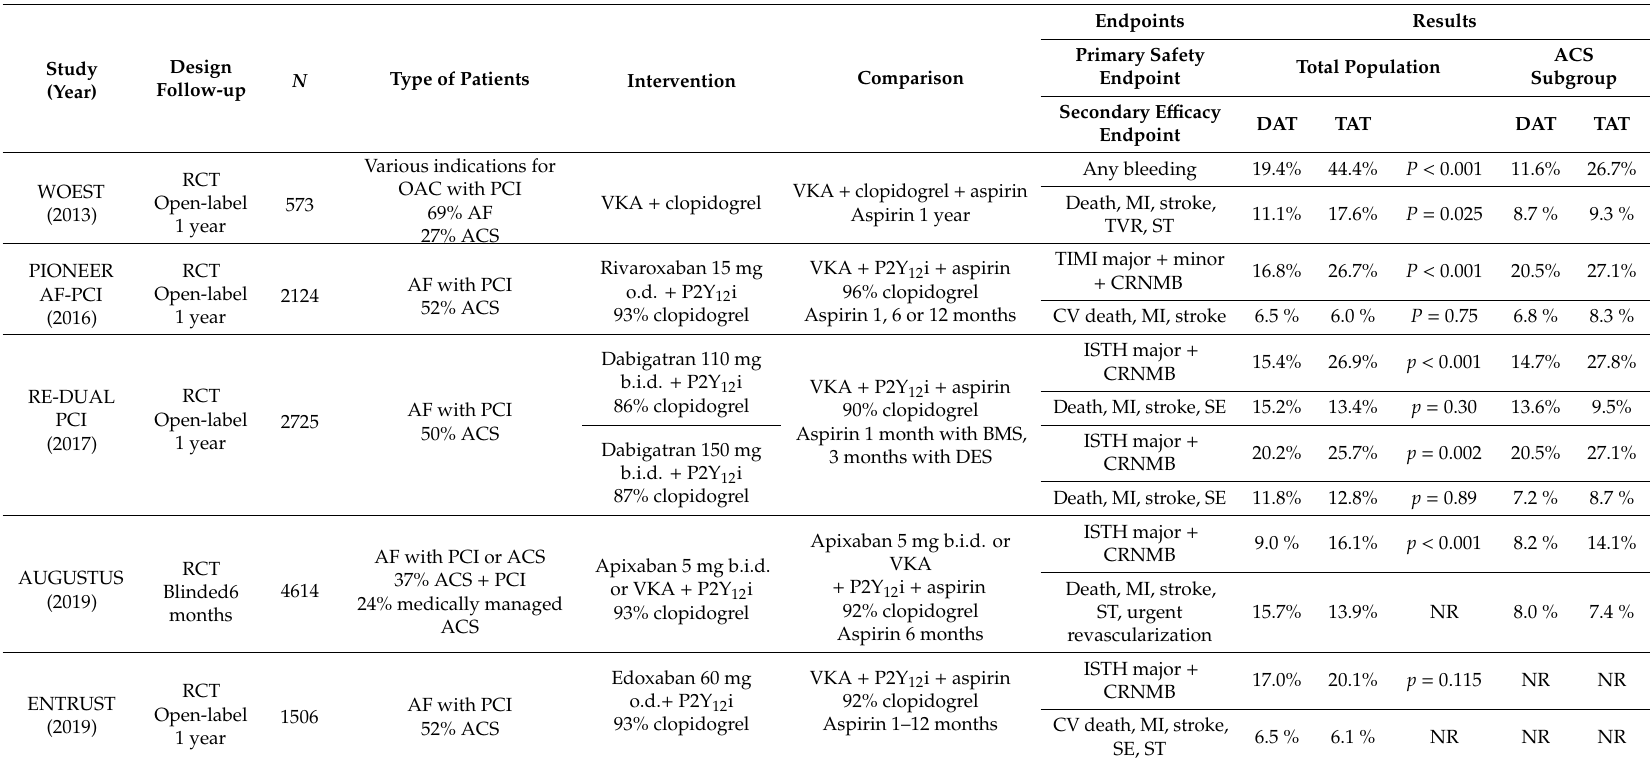
Table 1. Trials of dual and triple